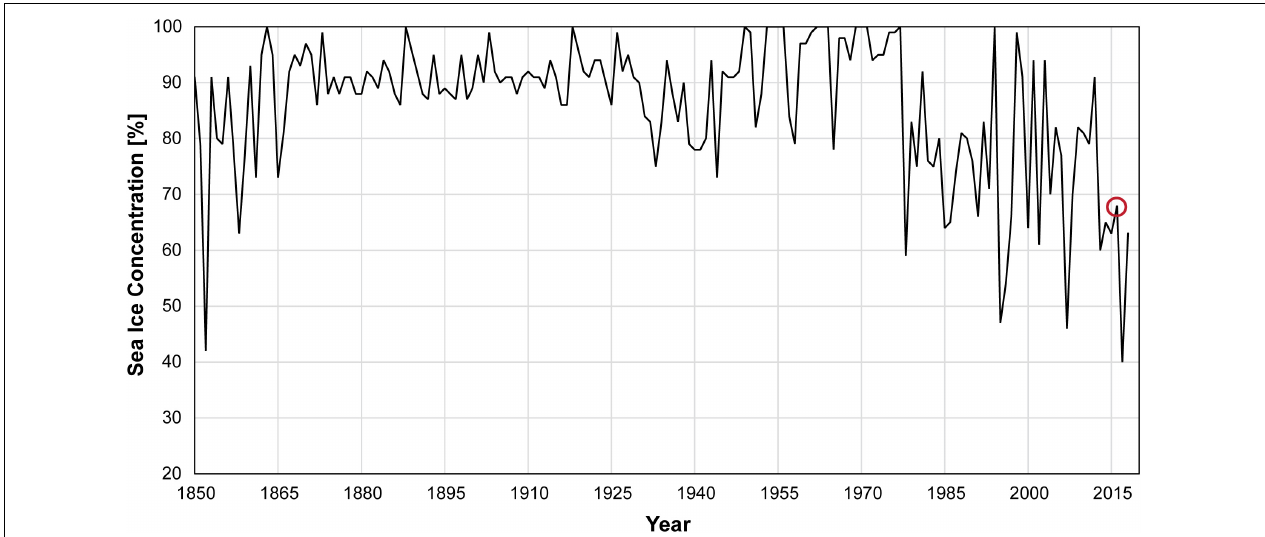
FIGURE 12 | Sea ice concentration compiled from the Alaska Ocean Observatory Network (AOOS) Sea Ice Atlas for the month of December between 1850 and 2018 at the mouth of Kotzebue Sound (67.00 ◦ N, -164.50 ◦ W). (0–30%) Open Water to very open drift, (30–90%) open drift to close pack, (90–100%) very close pack to compact. December 2016 (noted by the red circle) represents the 17th lowest December sea ice concentration over the entire 168-year record (Alaska Ocean Observing System [AOOS], 2014).